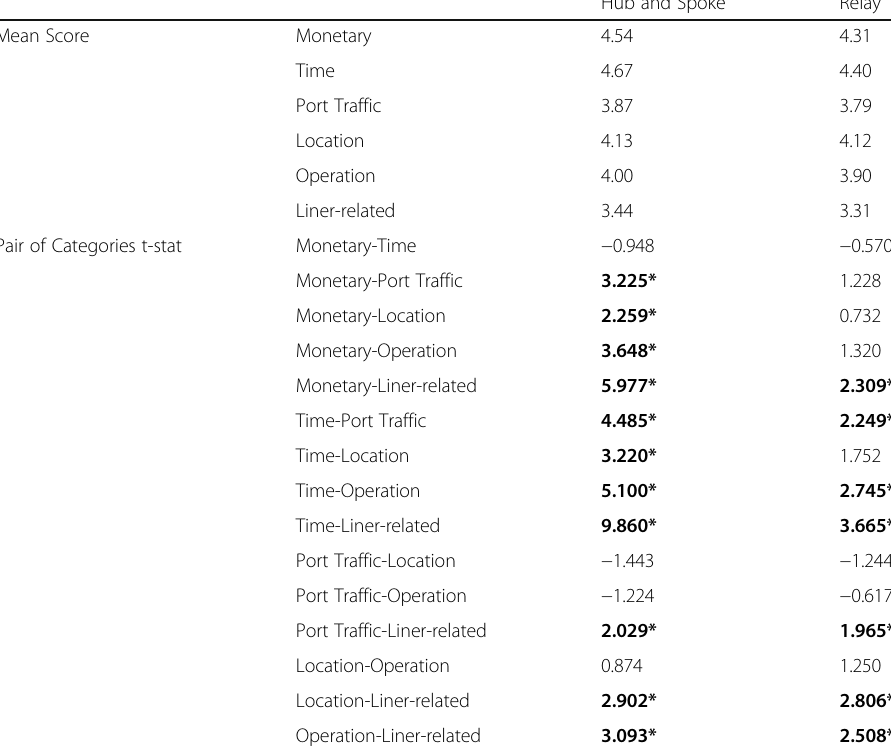
Hub and Spoke Relay